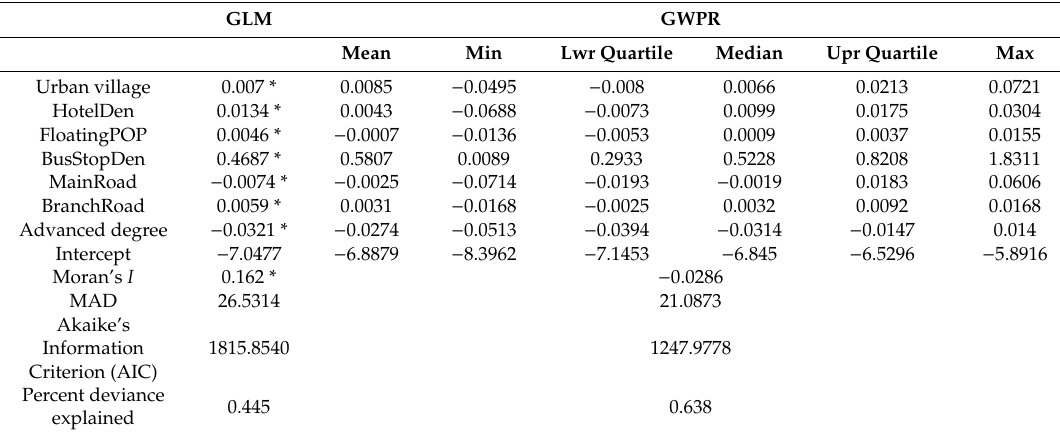
Table 3. Estimation of GLM and GWPR models.